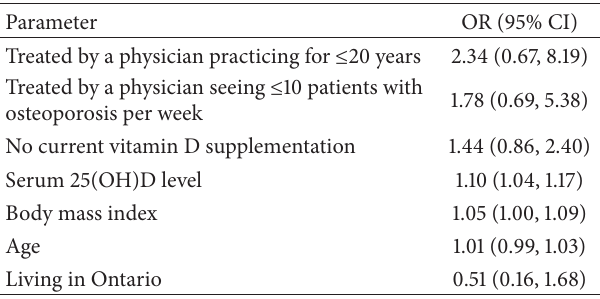
Figure 3: Serum 25(OH)D levels by prescribed level of vitamin D supplementation ( 𝑛 = 718 ). Note: numbers may not add to 100 due to rounding. Table 2: Results of multivariable GEE analysis examining potential associations with perception of “satisfactory” vitamin D levels.